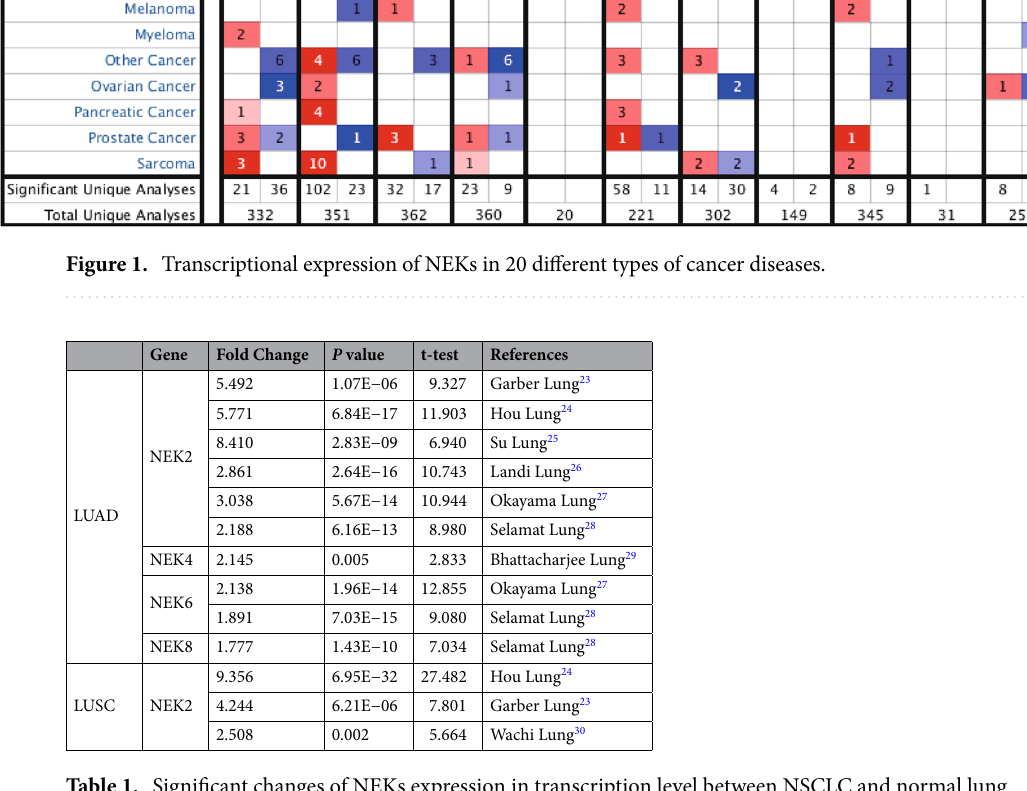
Table 1. Significant changes of NEKs expression in transcription level between NSCLC and normal lung tissues.